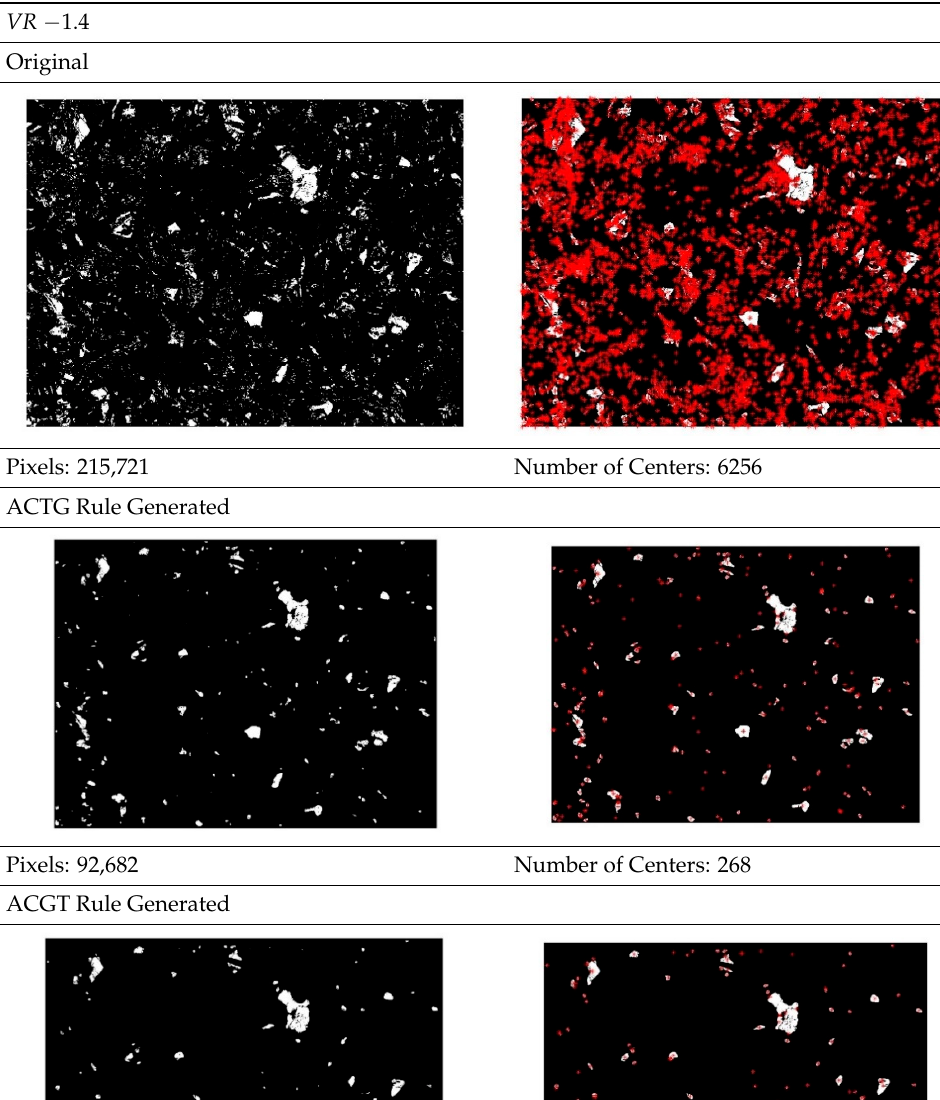
Table A10 . Images and associated pixels and number of centers corresponding to VR = − 1.4.